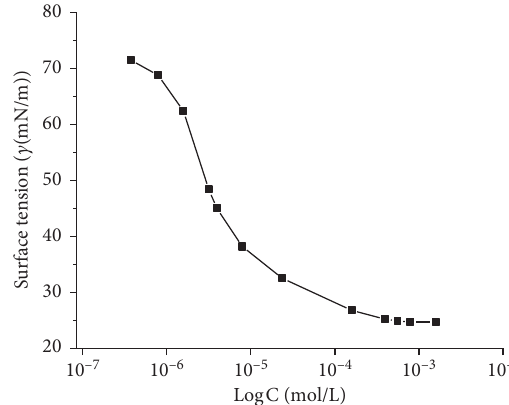
Figure 3: The surface tension of the amine-oxide.